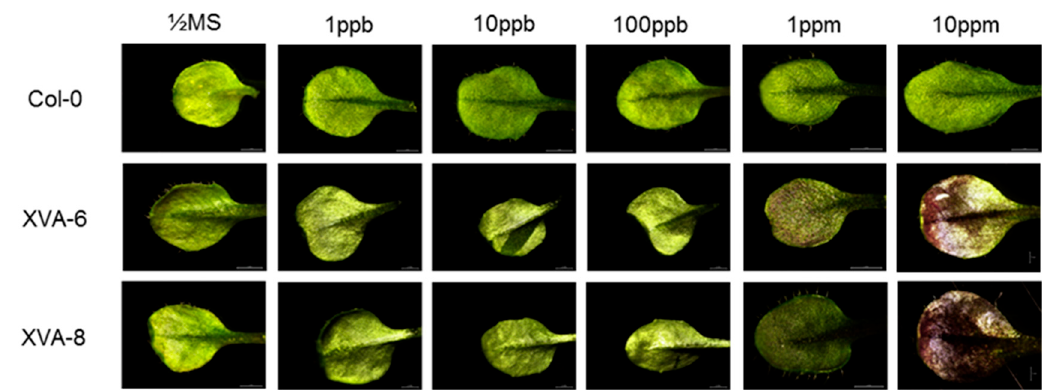
Figure 1. Anthocyanin production in leaves of transgenic XVA- PtrMYB119 Arabidopsis by DHT (dihydrotestosterone) treatment. The seeds were germinated on 1/2 MS agar medium containing different concentrations of DHT (0–10 ppm) and grown for 14 days.